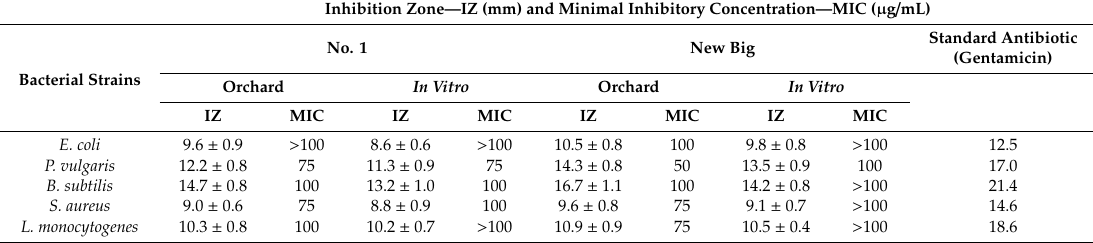
Table 6. Antibacterial activity and Minimal Inhibitory Concentration of leaves extracts and antibiotics against bacterial species tested by disc di ff usion